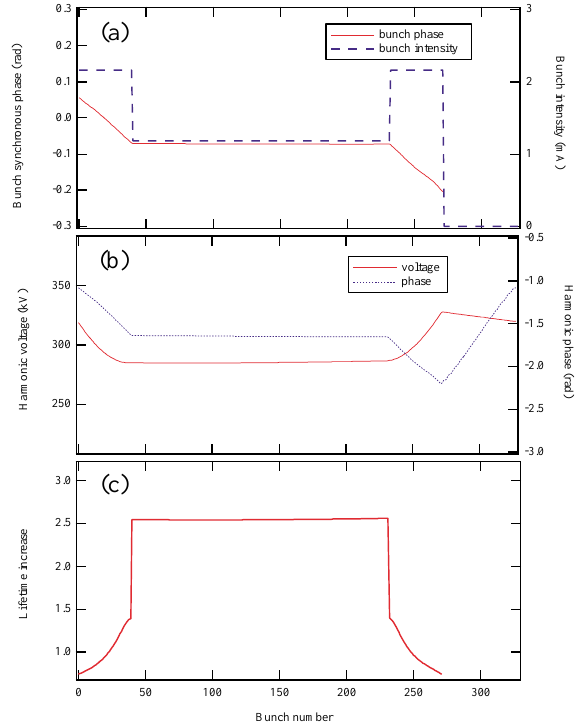
FIG. 10. (Color) Transient effects with a fill pattern which com- pensates for the beam loading over a large fraction of the bunch train. Average lifetime improvement is a factor of